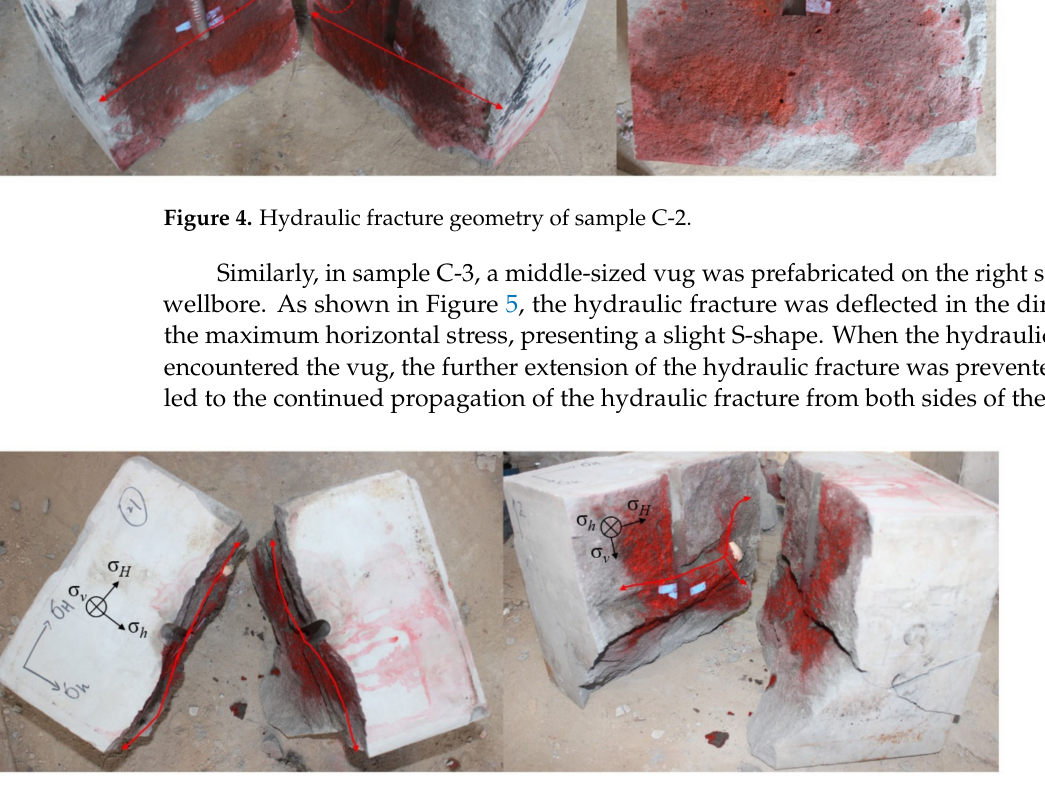
Figure 5. Hydraulic fracture geometry of sample